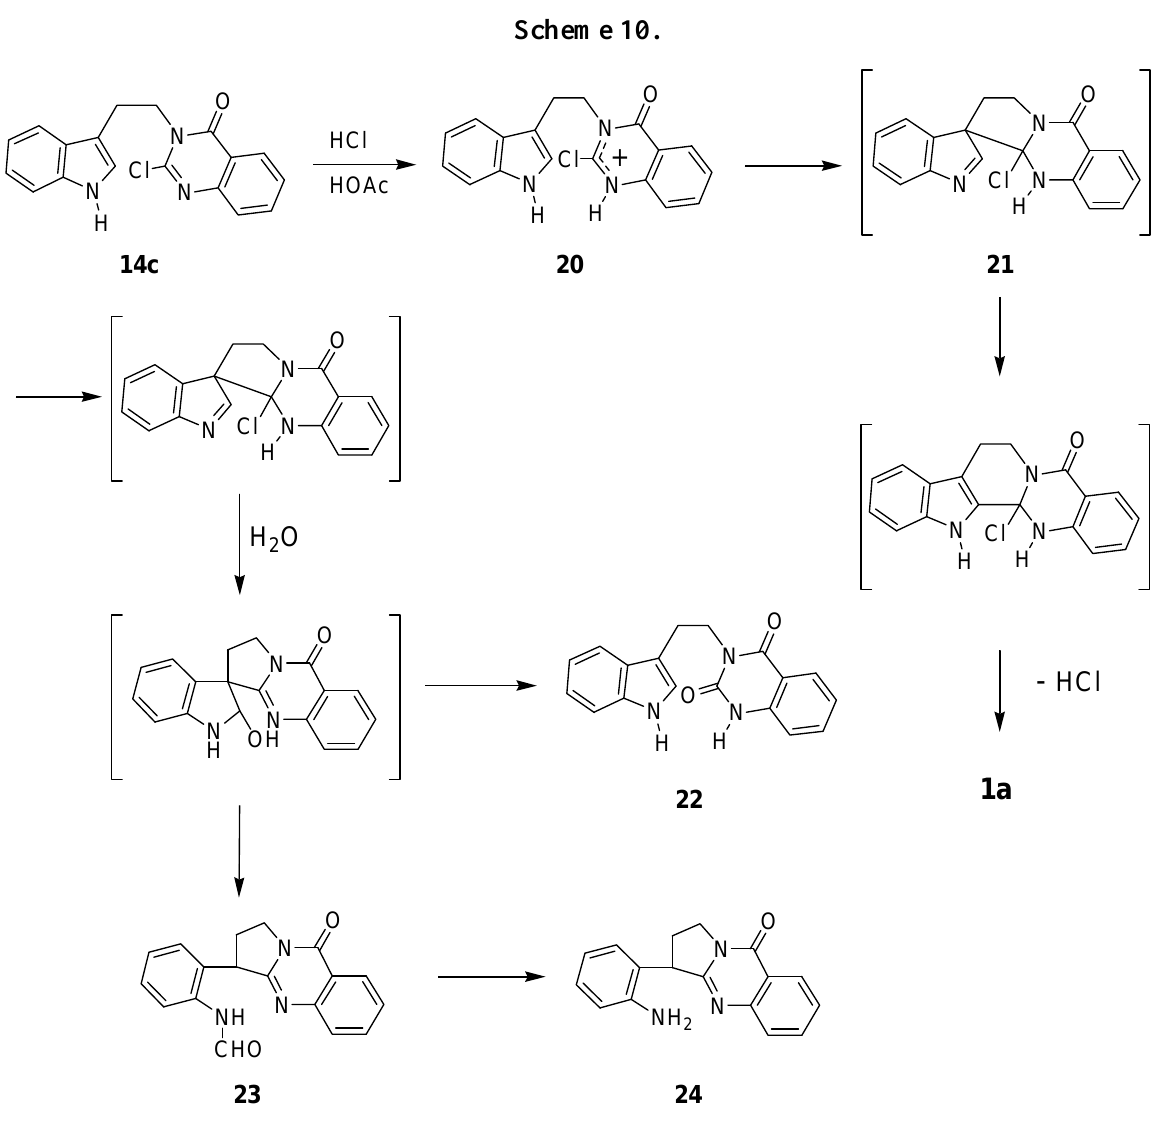
Table 6. Cyclization reaction of 14c under various acidic